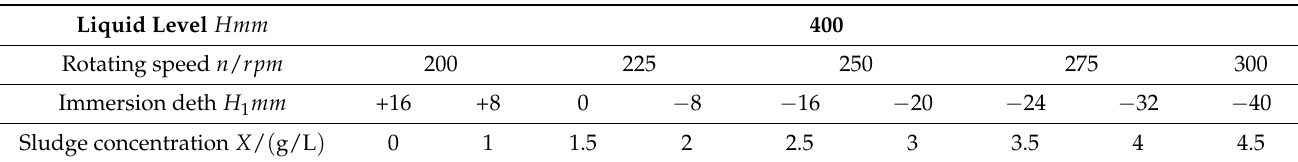
Table 2. Test scheme.